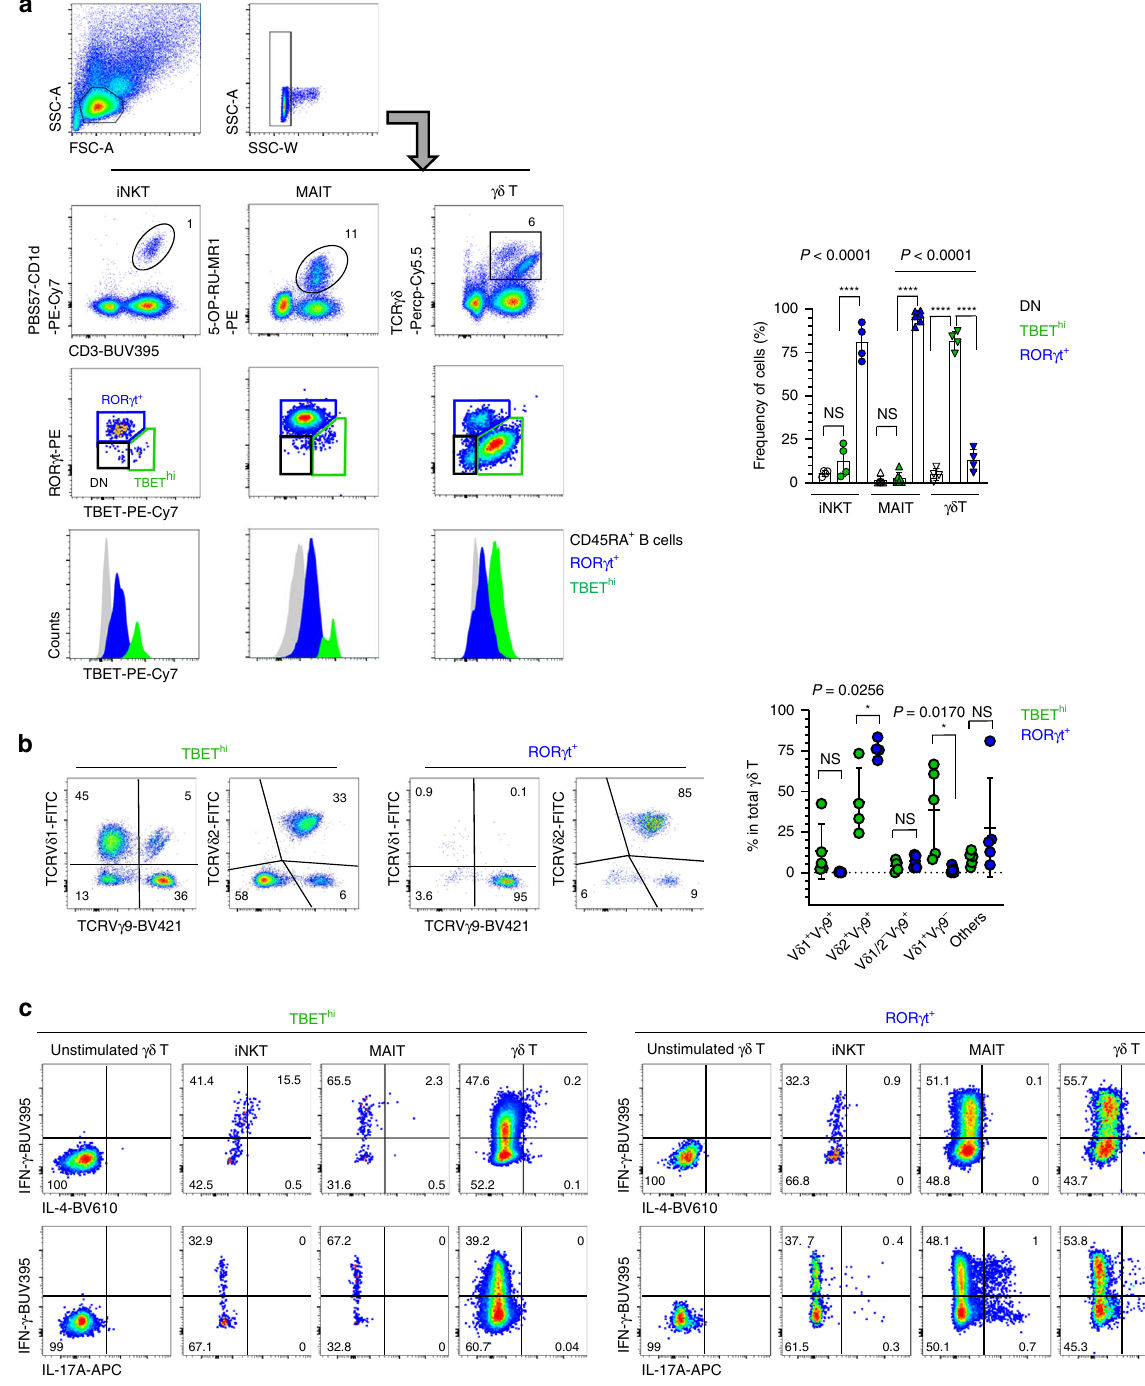
Fig. 7 Human and mouse innate T cells have analogous subsets. a Human mononuclear cells obtained from liver perfusion fl uid were stained with the indicated markers. Representative dot plots (left) show frequencies of iNKT (left), MAIT (middle), and γδ T cells (right) amongst total mononuclear cells. Representative FACS plots are from seven independent experiments and graph shows statistical analysis of their frequencies using pooled data ( n = 4 for NKT cell analysis, n = 6 for MAIT cell analysis, n = 4 for γδ T cell analysis). b Total γδ T cells from ( a ) were stained with the indicated anti-TCR antibodies and representative FACS plots are from three independent experiments (left) and graph shows pooled results of their frequencies with statistical analysis (right, n = 5 except V δ 2 + V γ 9 + cell analysis ( n = 4)). c Indicated cells were stimulated with PMA and ionomycin, and intracellularly stained with the anti- cytokine antibodies. Representative dot plots are shown from three independent experiments. Numbers indicated frequencies of cells in adjacent gates or each quadrant. Data are presented as mean ± SD. Unpaired two-tailed t -test was used. * P < 0.05, ** P < 0.01, *** P < 0.001, **** P < 0.0001. NS not signi fi cant ( P > 0.05). Source data are provided as a Source Data fi